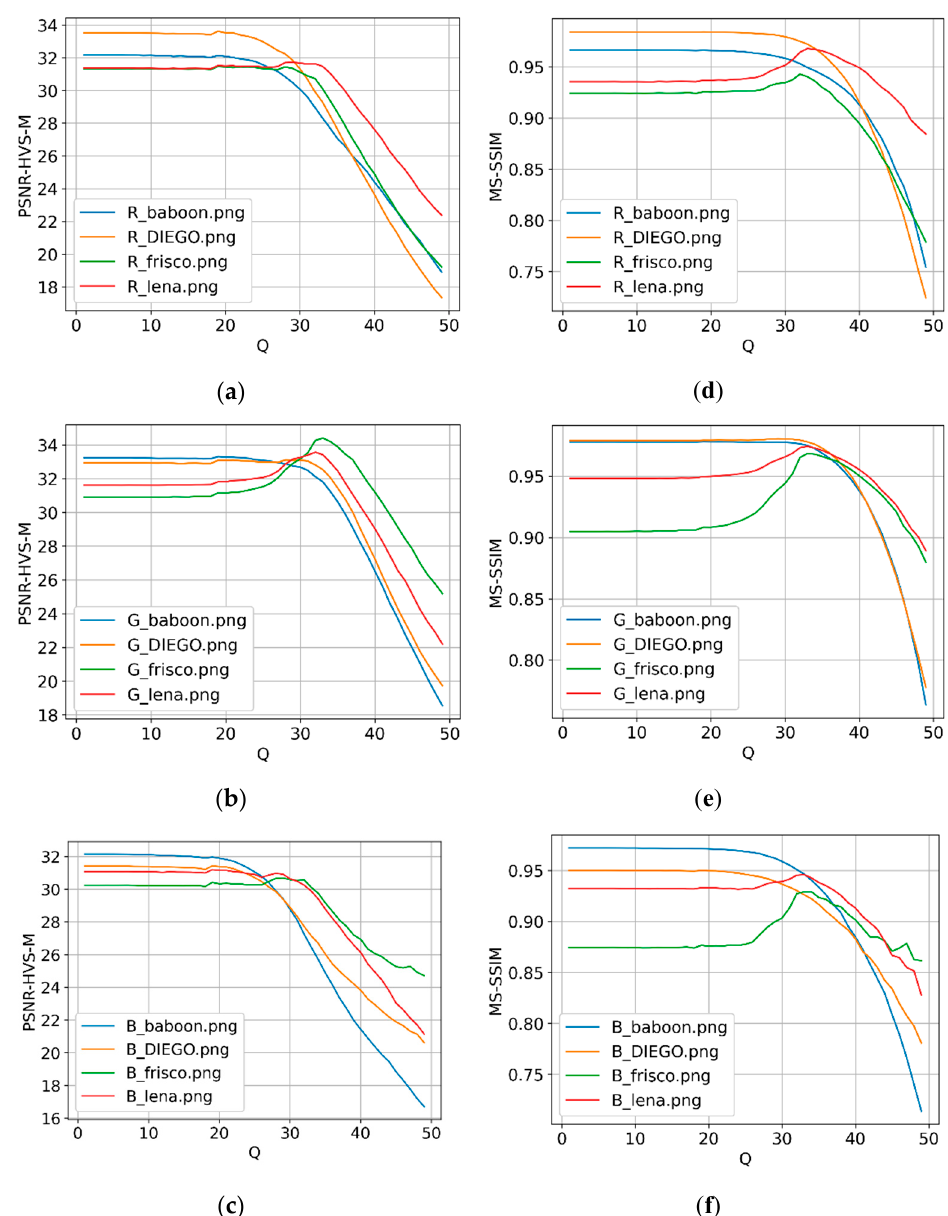
Figure 18. Dependences 𝑃𝑆𝑁𝑅 − 𝐻𝑉𝑆 − 𝑀 (cid:3047)(cid:3030) (𝑄) for R ( a ), G ( b ), and B ( c ), and 𝑀𝑆 − 𝑆𝑆𝐼𝑀 (cid:3047)(cid:3030) (𝑄) de- pendences for R ( d ), G ( e ), and B ( f ) component images.